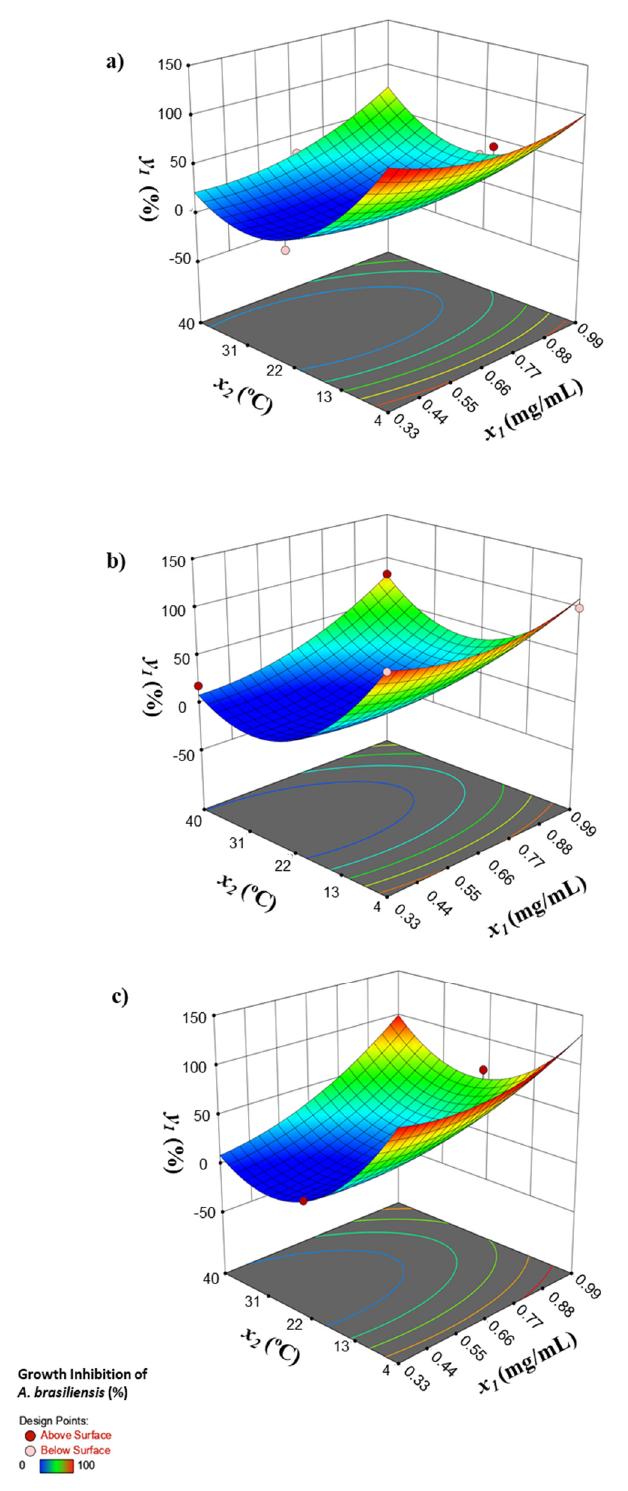
Figure 1. Growth inhibition of A. brasiliensis (%) as a function of the concentration of the biosurfactant ( x 1 ) and temperature ( x 2 ) of incubation for di ff erent incubation times ( x 3 ): ( a ) 5, ( b ) 8, and ( c ) 11 days. 266 Regarding C. albicans , all three independent variables-biosurfactant concentration ( x 1 ), 267 temperature ( x 2 ), and time ( x 3 )-were found to be statistically significant ( p < 0.05), influencing the 268 growth inhibition of the pathogenic strain (see Table 3). Additionally, the interaction between the 269 biosurfactant concentration ( x 1 ) and incubation temperature ( x 2 ) was found to be statistically 270